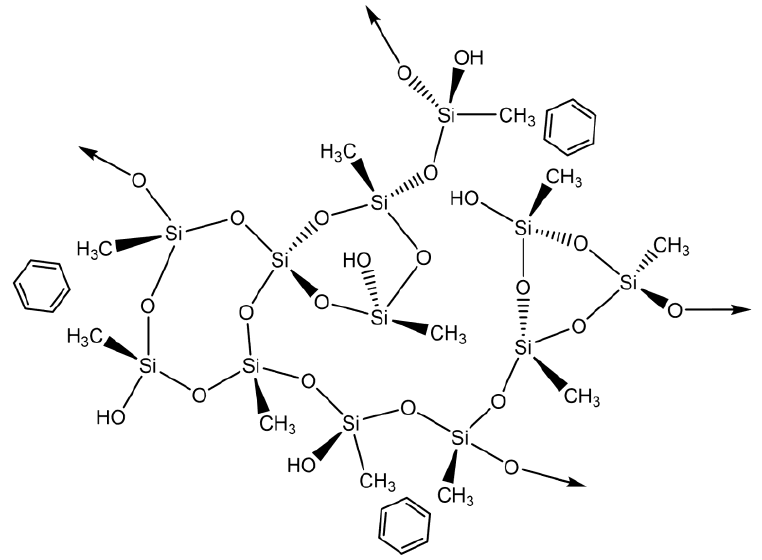
10 of 30 Figure 2. ( a ) — Experimental equilibrium data and the best fitted isotherm model for adsorption of benzene into the studied aerogels (solid line — Freundlich; dashed line — BET). ( b ) — Representative plots of the fit of nonlinearized form of pseudo-second order equation (solid line) to the data of experimental adsorption capacity as function of time, for the studied adsorbents towards benzene ( C 0 = 100 ppm, 15 rpm, 20 °C). When CNTs were added into the silica matrix, the BET model provided the most adequate results, indicating multilayer adsorption. However, in the case of sample 100M_CNT-HNO 3 _10, the difference between the AIC values of the Langmuir and BET models was lower than two (Table S1), indicating that both models have statistical sup- port. The Akaike weights were determined in order to select the best model among